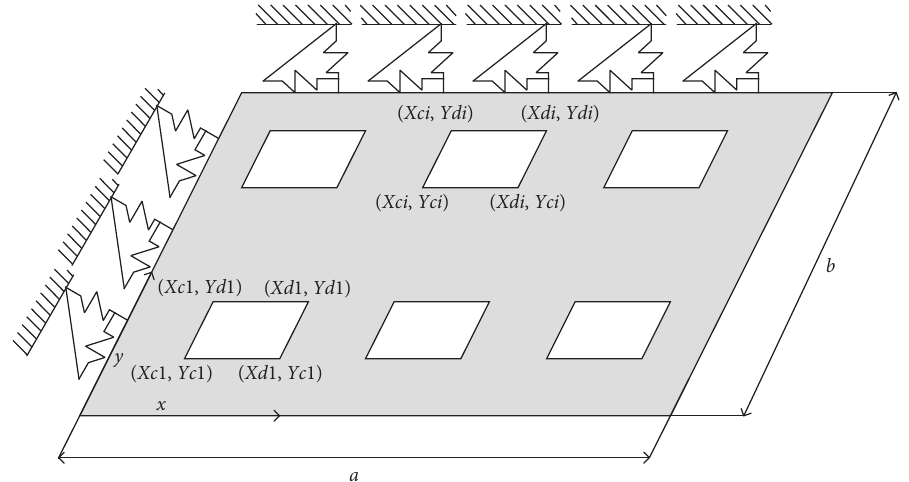
Figure 1: The geometric sketch of the rectangular plate with